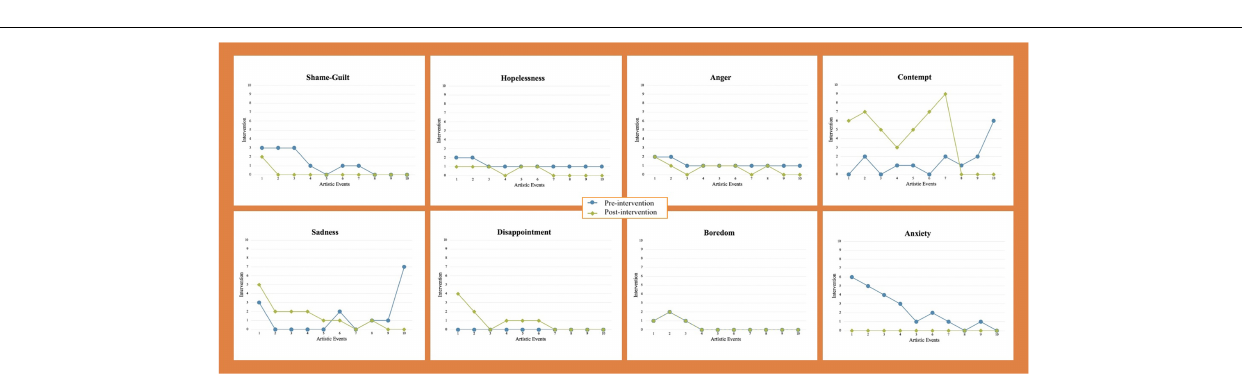
Frontiers in Psychology |